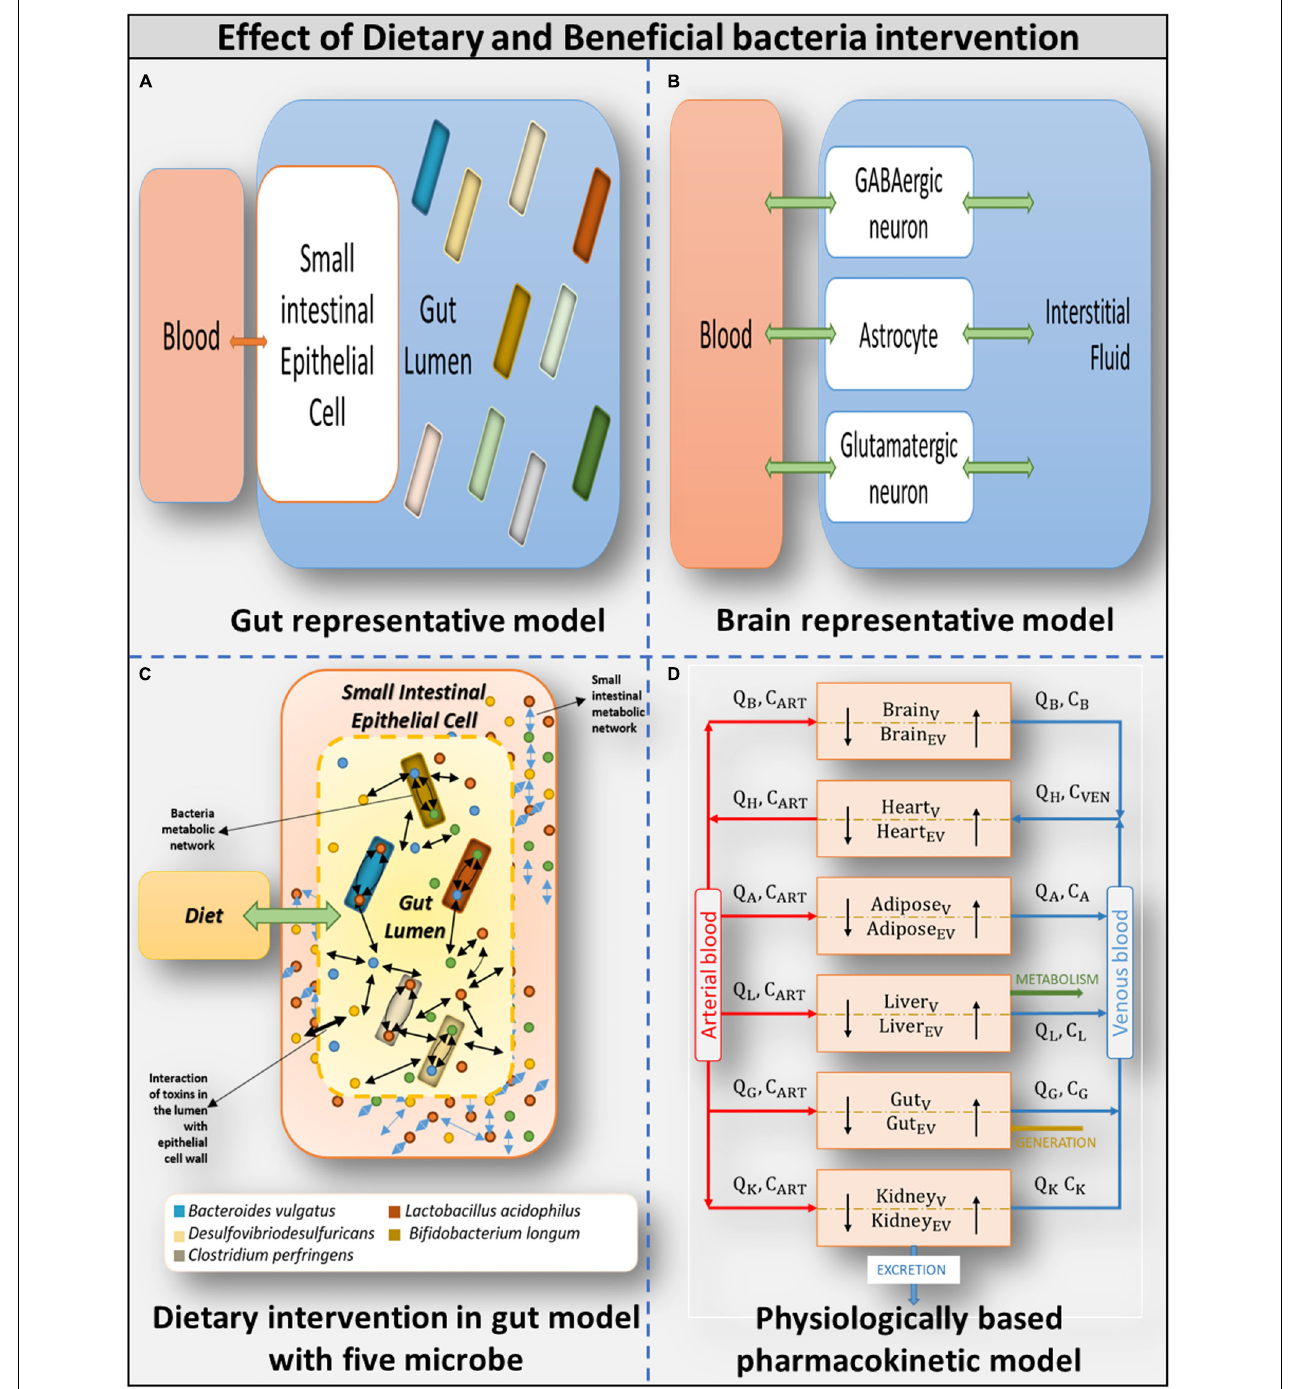
FIGURE 3 | Overview of models used (A) Gut representative model: Overall integrated Gut representative model. (B) Brain representative model: Brain model and its components. (C) Dietary intervention in gut model with five model: Gut representative model interacting with diet and host-microbe and microbe-microbe interaction. (D) Physiologically based pharmacokinetic model: Whole-body PBPK model.